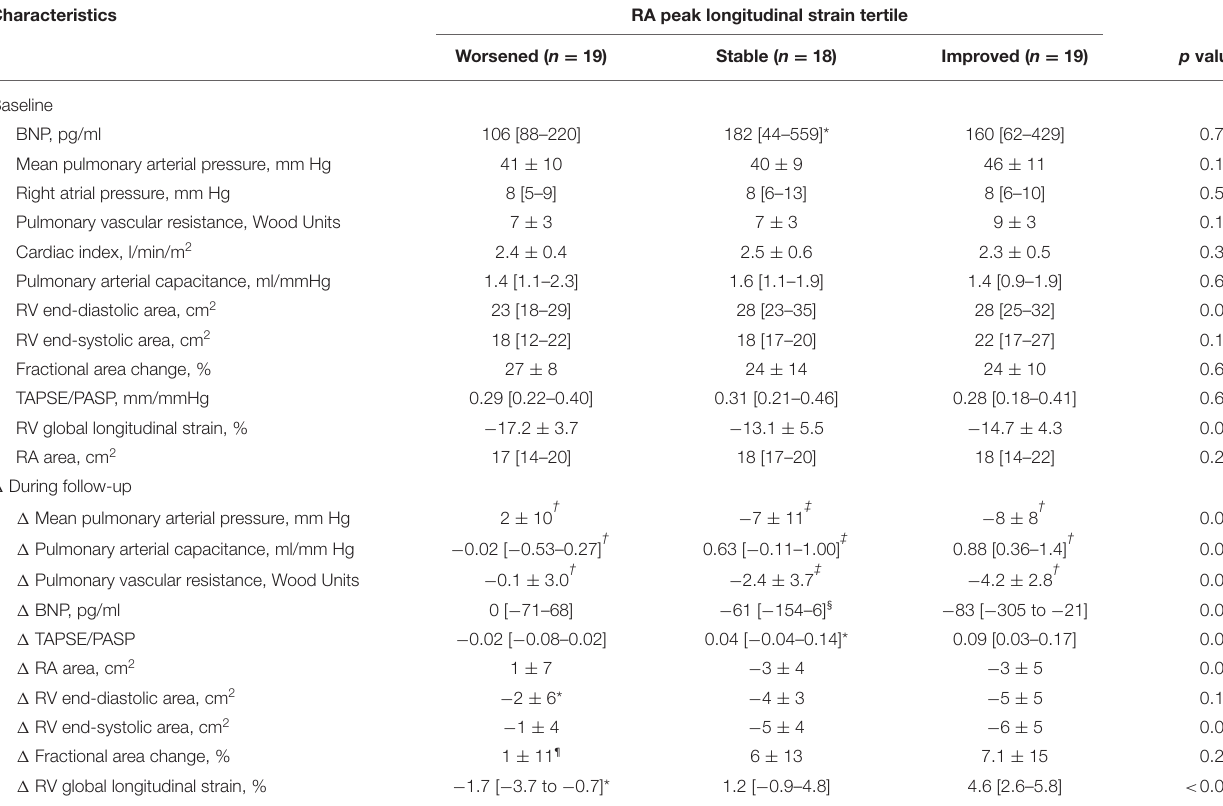
TABLE 3 | Key baseline parameters and changes during follow-up stratified by tertile of longitudinal RA function.